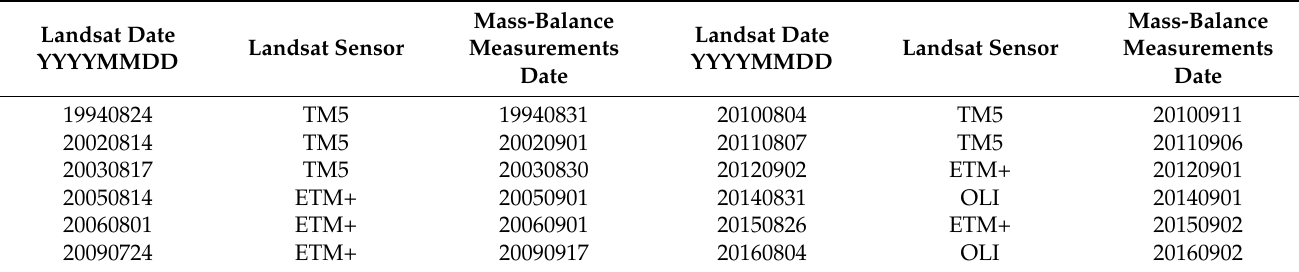
Table 2. Landsat data were used to retrieve the snow line altitudes (SLAs). The mass balance measurement data were employed to calculate the equilibrium line altitudes